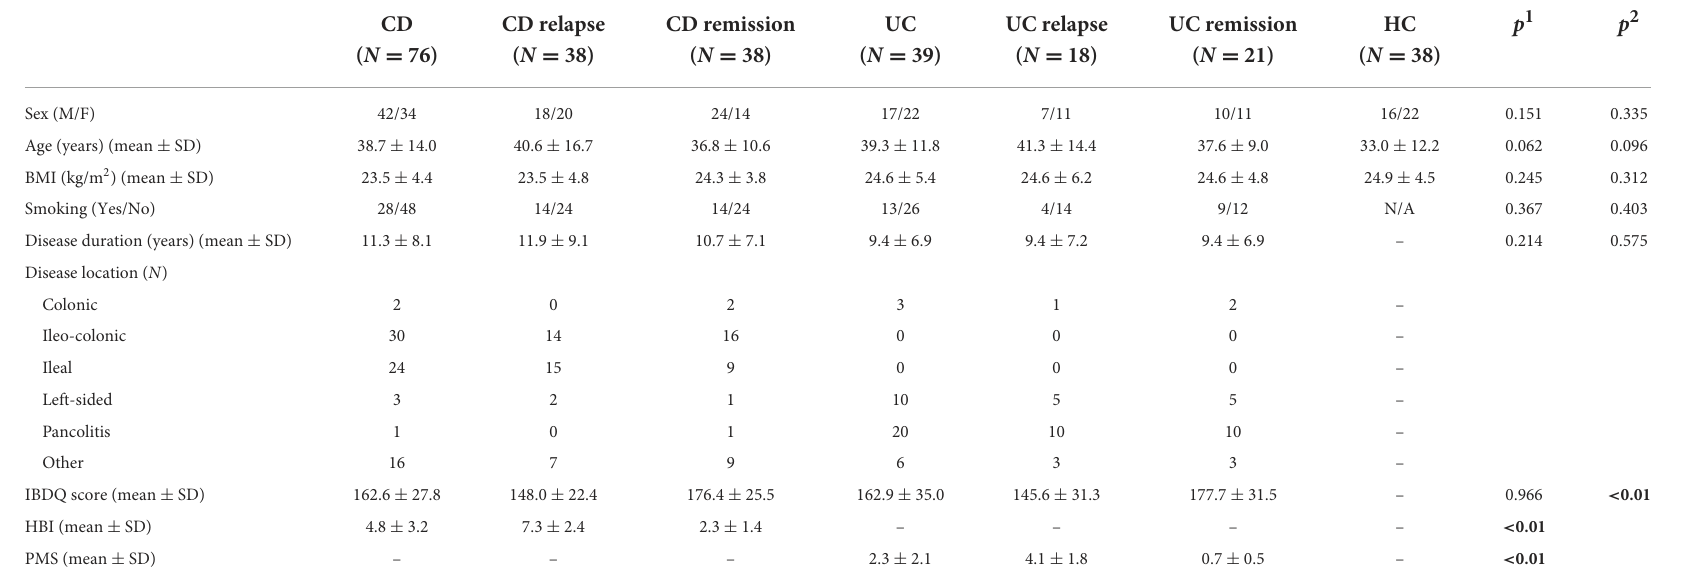
TABLE 1 Demographic and clinical characteristics of the participants.